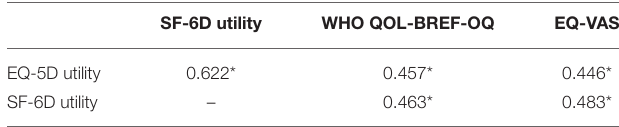
TABLE 2 | Correlation of EQ-5D and SF-6D with WHO QOL-BREF-OQ and EQ-VAS.